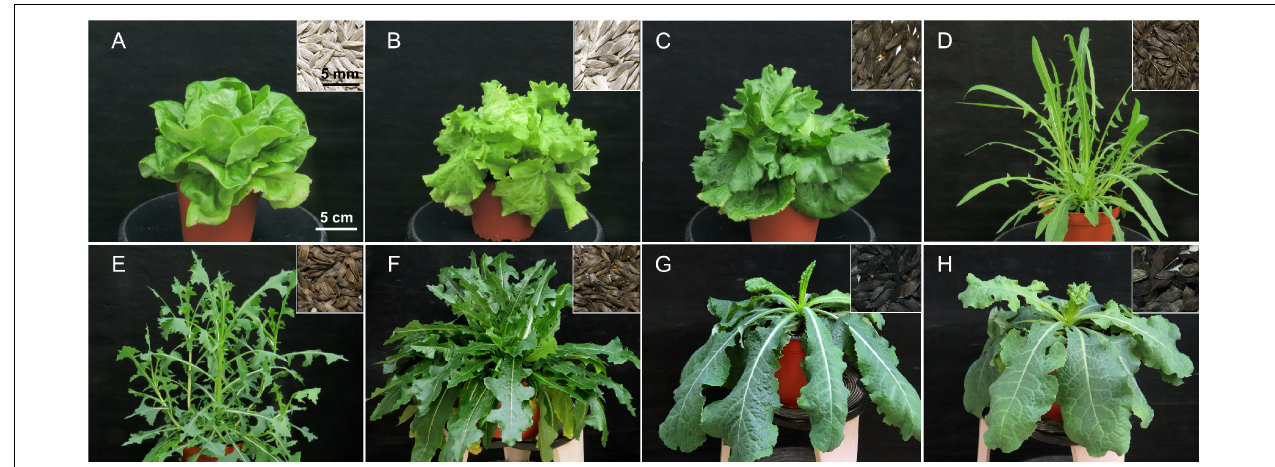
FIGURE 1 | Phenotypes of the selected Lactuca at the rosette stage and corresponding seeds. (A) L. sativa LACWendel; (B) L. sativa LAC004500; (C) L. sativa US12100; (D) L. saligna LAC008020; (E) L. serriola CGN004799; (F) L. serriola LAC005780; (G) L. virosa CGN013357; (H) L. virosa LAC006941. L. virosa CGN019045 is not represented but it is similar to the two others L. virosa accessions, in terms of leaves and seeds shape and color.